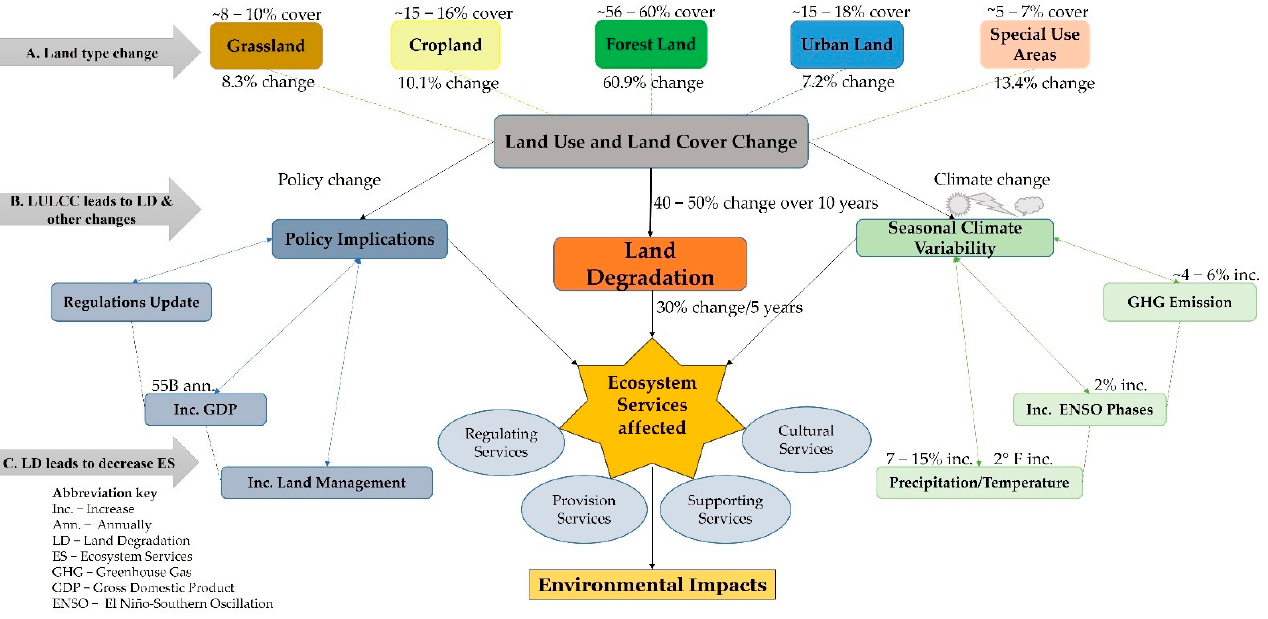
Figure 4. A. Schematic illustration of LULCC in the SEUS from 1945 to 2012 [13,58]; B. Land degradation changes from LULCC over ten years [13,15,59–65]; C. Land degradation changes that lead to percentage depletion of ecosystem services [66,67].